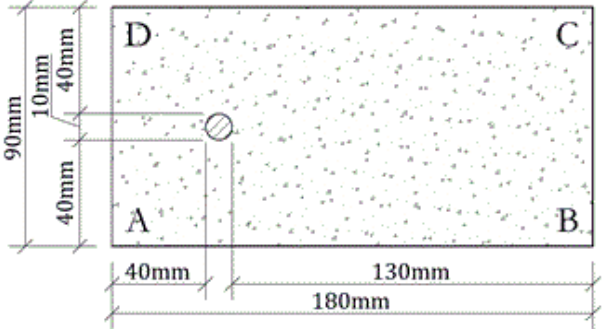
Figure 4 – Application 1. Specimen geometry